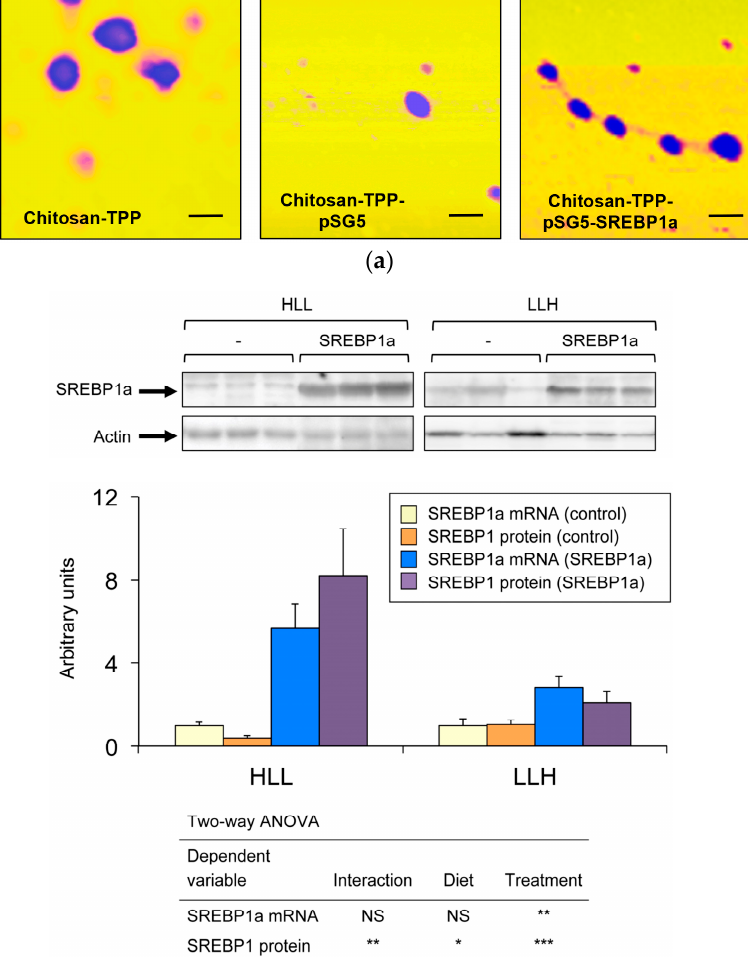
Figure 1. Effect of chitosan-TPP-pSG5-SREBP1a administration on SREBP1 mRNA and immunodetectable levels in the liver of S. aurata . ( a ) Representative images of chitosan-TPP, chitosan-TPP-pSG5 and chitosan-TPP-pSG5-SREBP1a nanoparticles obtained by atomic force microscopy. Black bars correspond to 200 nm. ( b ) The upper part of the panel shows a representative Western blot analysis of immunodetectable SREBP1 levels in liver extracts of of S. aurata fed diet HLL (high protein, low lipid, low carbohydrate) or LLH (low protein, low lipid, high carbohydrate) following 72 h of intraperitoneal administration with chitosan-TPP nanoparticles complexed with 10 μ g/g BW of pSG5 (-) or pSG5-SREBP1a (SREBP1a). Two independent experiments were performed. The lower part of the panel shows the effect of chitosan-TPP-pSG5 (control) and chitosan-TPP-pSG5-SREBP1a (SREBP1a) nanoparticle administration on SREBP1 mRNA and protein levels in the liver of S. aurata fed diet HLL or LLH. Analysis of SREBP1 mRNA levels relative to the geometric mean of ribosomal subunit 18s, β -actin and EF1 α were performed by RT-qPCR in liver samples of S. aurata at 72 h post-treatment. The values are expressed as mean ± standard error of the mean (SEM) ( n = 6–7). Statistical significance for independent variables (diet and treatment) is indicated as follows: * p < 0.05; ** p < 0.01; *** p < 0.001; NS not